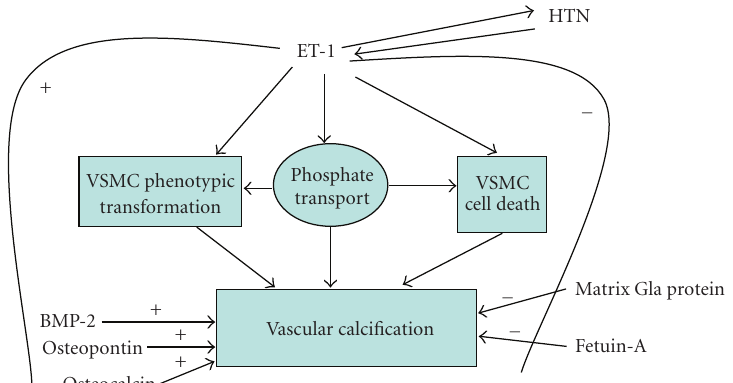
Figure 4: A simplified schematic of some of the putative e ff ects of endothelin-1 (ET-1) leading to vascular calcification discussed in this